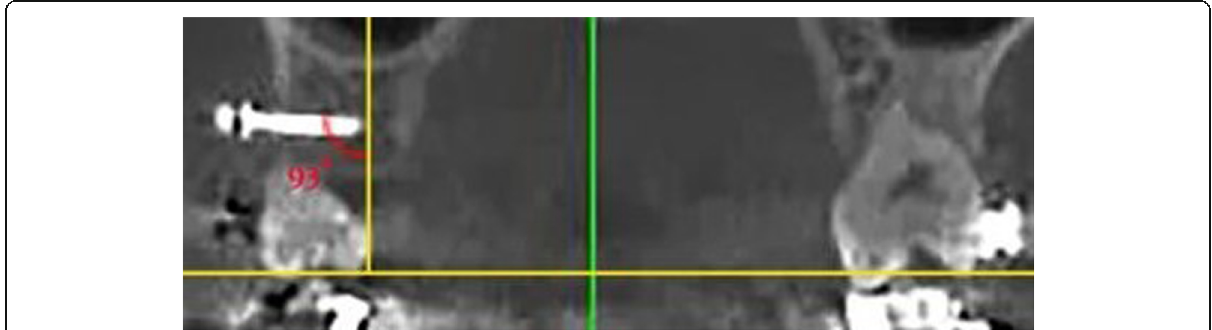
Fig. 2 Coronal cross-sectional CBCT image for measuring the insertion angle of